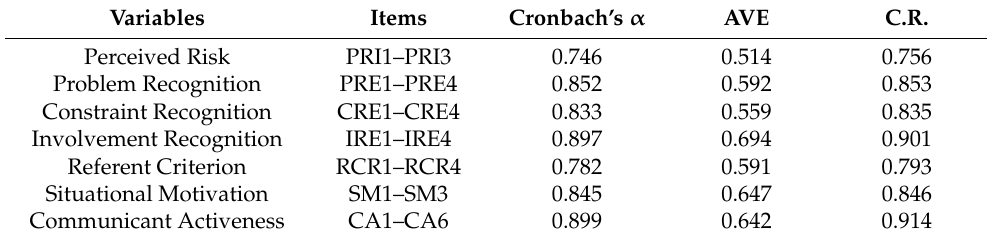
Table 3. Reliability and convergent validity analysis of scales.